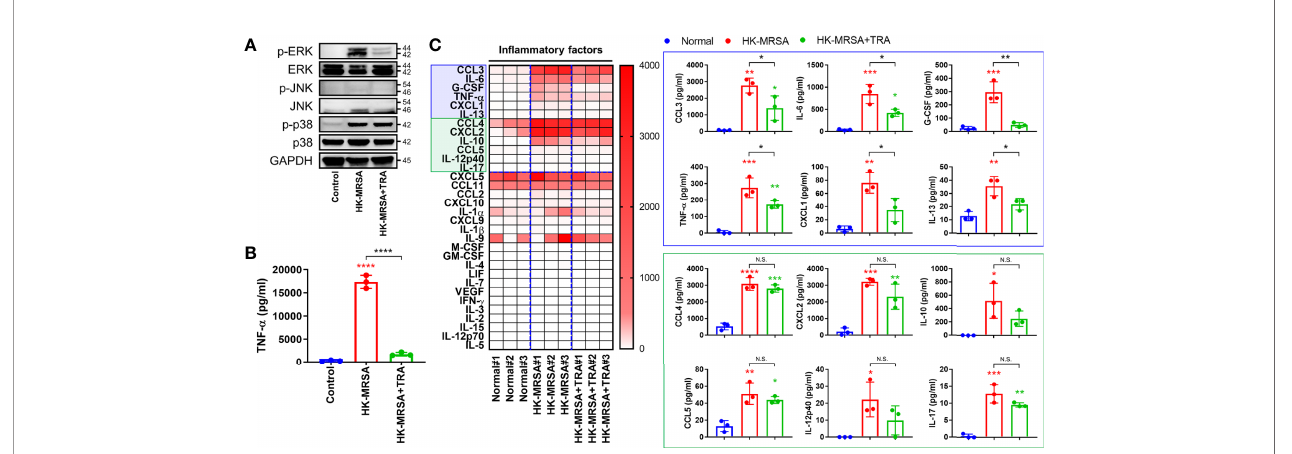
FIGURE 5 | Trametinib inhibited production of pro-in fl ammatory markers induced by HK-MRSA. (A) The murine macrophage cell line, RAW264.7, was treated with trametinib (200 ng/mL) for one hour and inoculated with HK-MRSA (4×10 6 CFU) for 30 minutes. Expression of p-ERK, ERK, p-JNK, JNK, p-p38, and p38 in whole protein was measured, with GAPDH serving as a loading control. (B) TNF- a concentrations in RAW264.7 cells under control conditions, inoculated with HK-MRSA (4×10 6 CFU) for 12 hours, or treated with trametinib (200 ng/mL) for one hour and infected with HK-MRSA (4×10 6 CFU) for 12 hours. (C) Murine blood treated with Trametinib (20 ng/mL) for 1 hour and then inoculated with HK-MRSA (4×10 6 CFU) for 6 hours generated in fl ammation, with increased expression of cytokines, chemokines, and growth factors in serum ( n = 3 per group). Blue and green boxes enclose in fl ammatory mediators that were signi fi cantly upregulated by HK-MRSA. Those encompassed by the blue box also represent in fl ammatory mediators with expression partially or completed rescued by trametinib treatment. Error bars show means ± SD. One-way ANOVA with Tukey ’ s post hoc analysis was used to assess statistical signi fi cance when compared to the control and normal group or HK- MRSA group (* p <0.05 or ** p < 0.01 or *** p < 0.001 or **** p < 0.0001; N.D., not detected). N.S., Not Signi fi